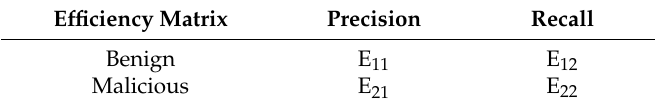
Table 2. Definition of Efficiency Matrix